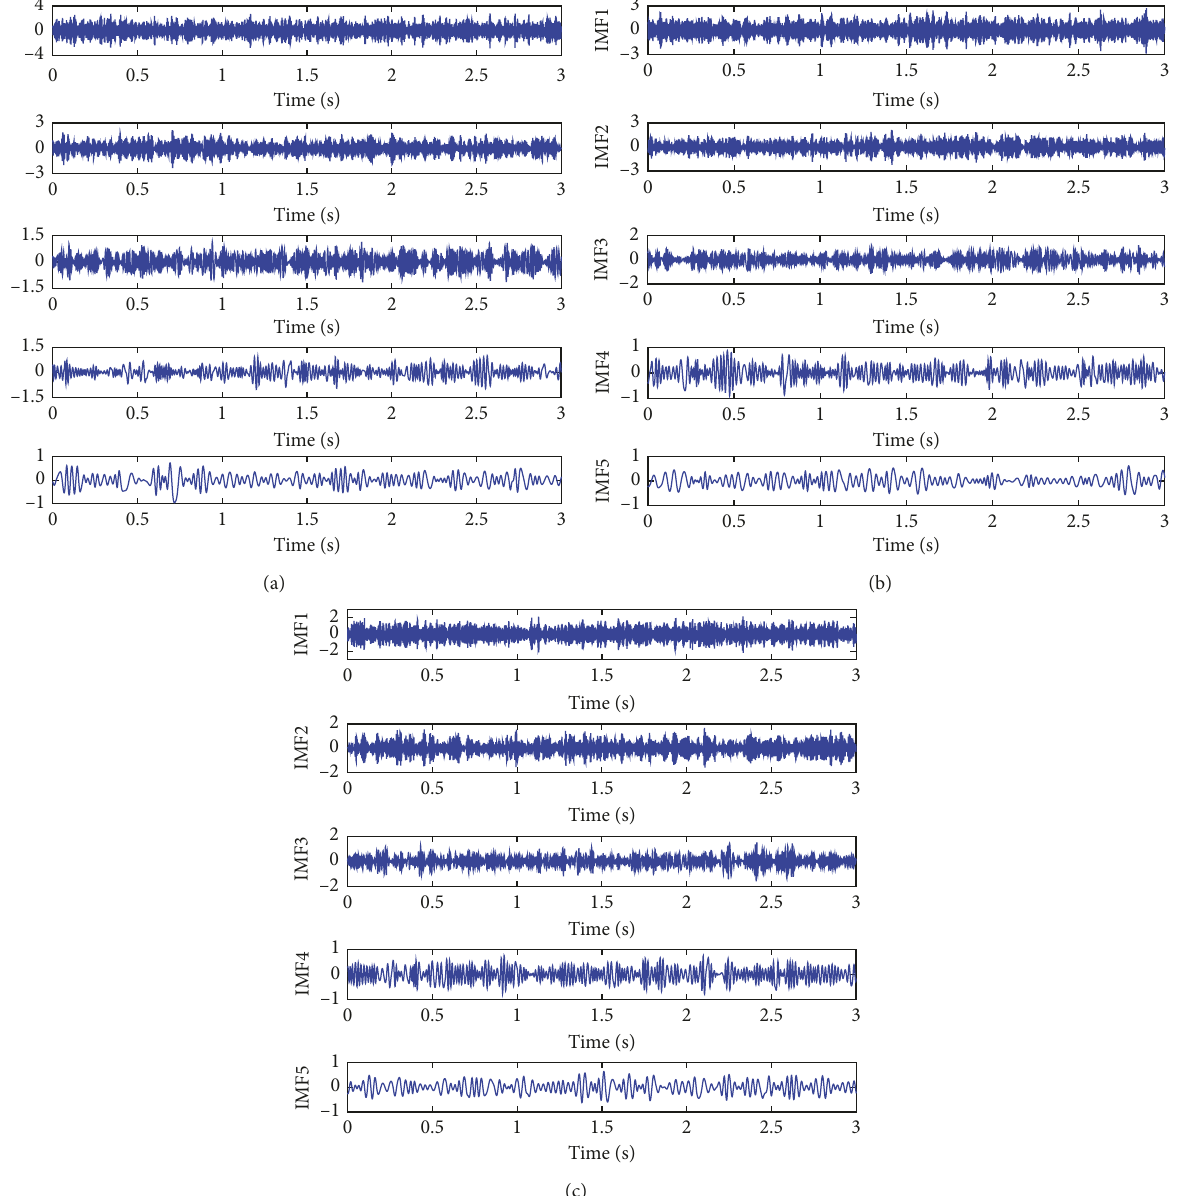
Figure 9: EMD results of response signals of three types of piezoelectric patches when noise signals are added: (a) normal piezoelectric patch; (b) broken piezoelectric patch; (c) degummed piezoelectric